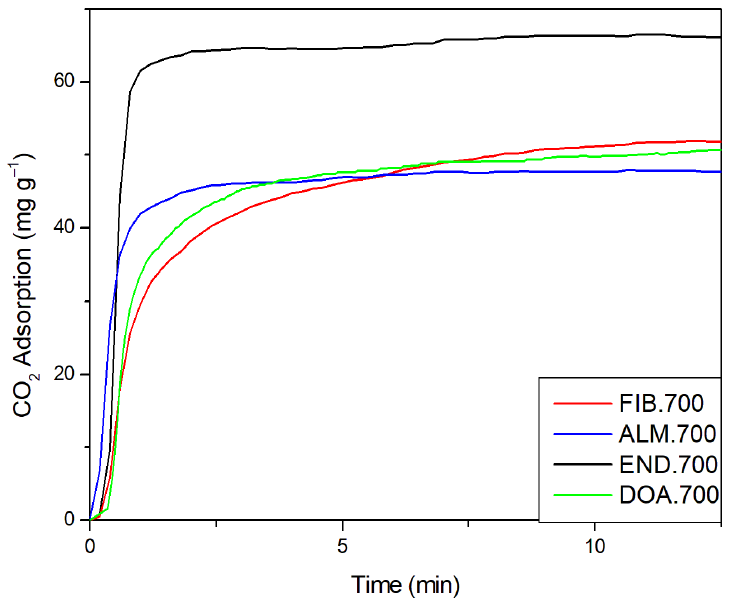
Figure 5. CO 2 adsorption capacity of biochars from FIB, ALM, END, and DOA.